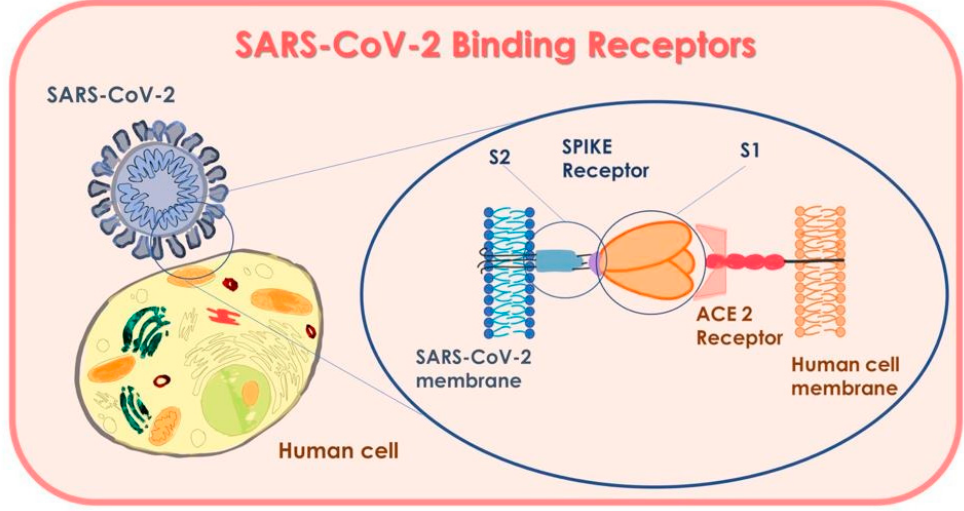
Figure 4. SARS-CoV-2 Binding Receptors.